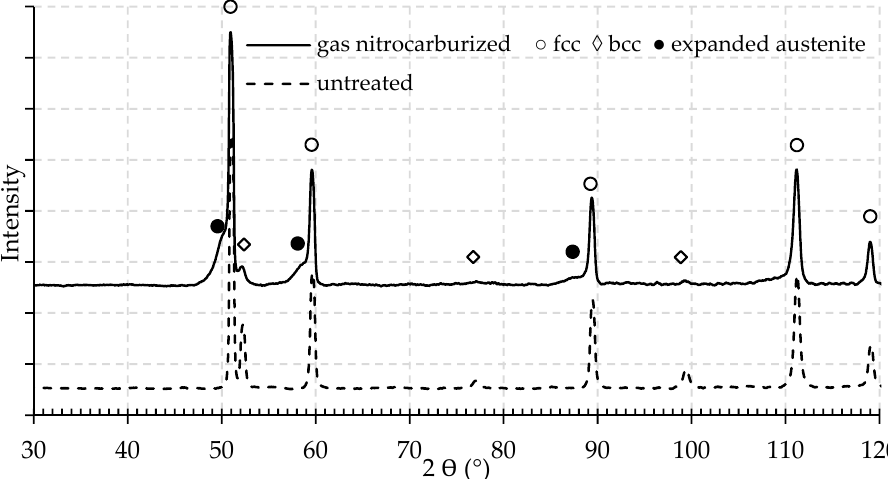
Figure 3. Diffraction diagrams of gas nitrocarburized and untreated AISI 316L powder feedstocks.